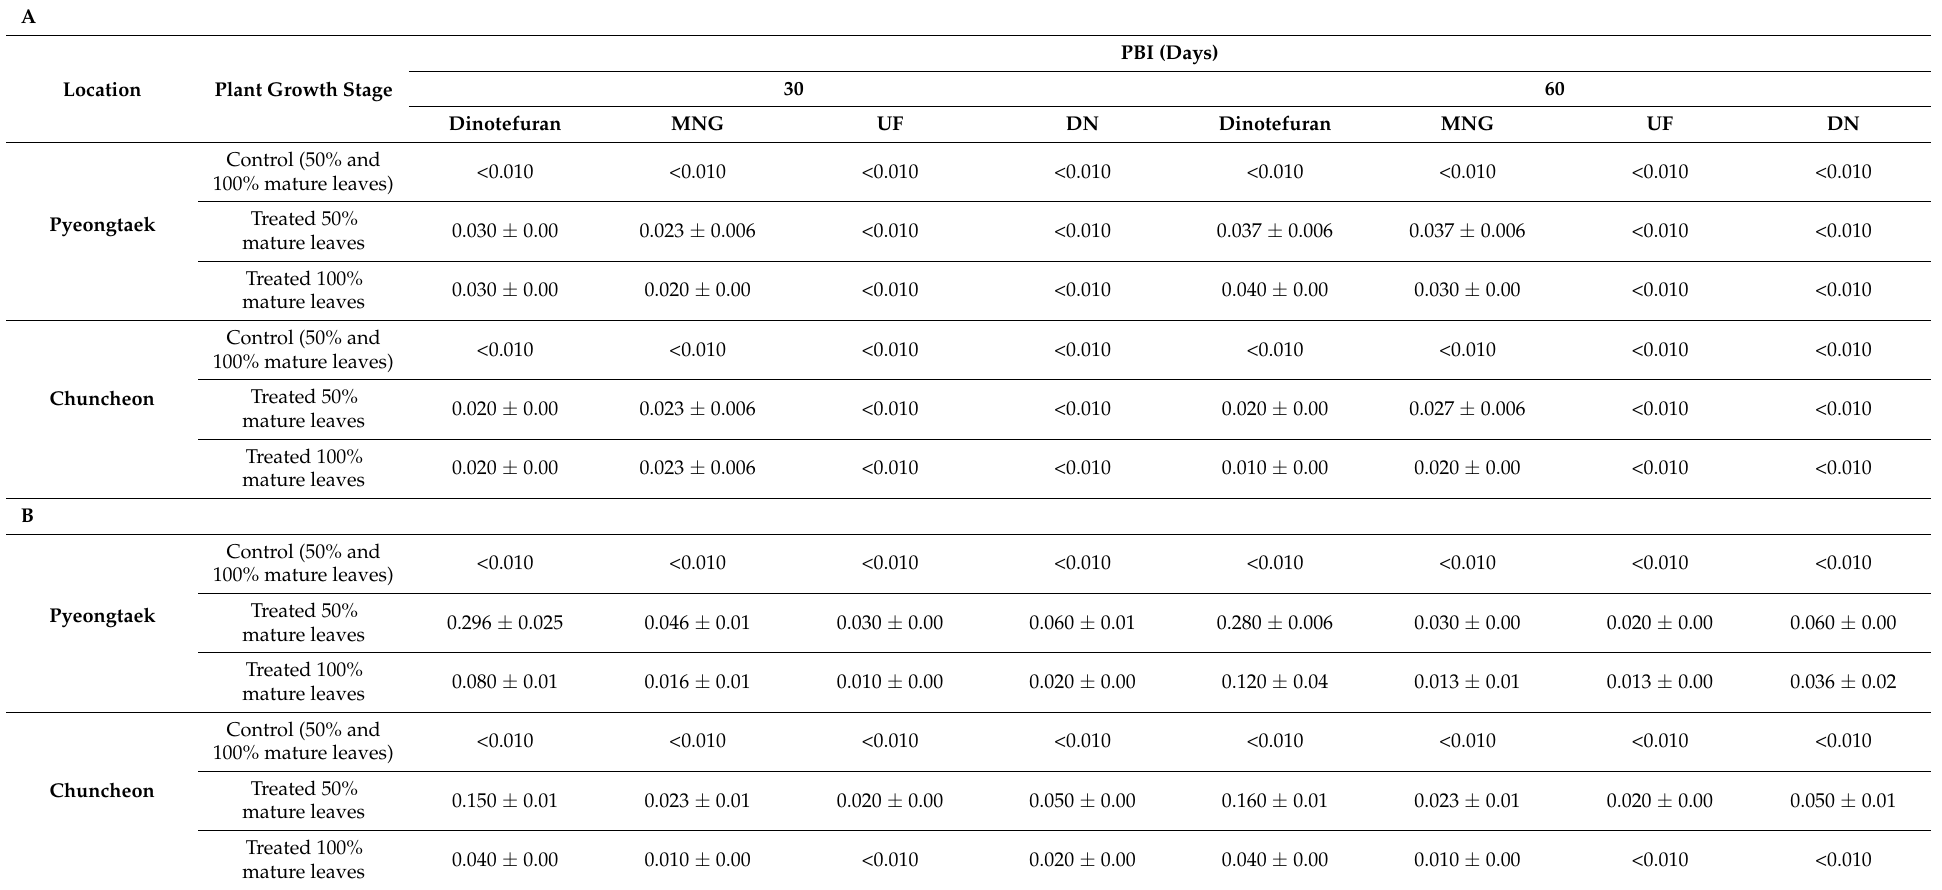
Table 3. Means * of dinotefuran and its metabolite residues (mg/kg) detected in ( A ) lettuce leaves and ( B ) celery shoots.